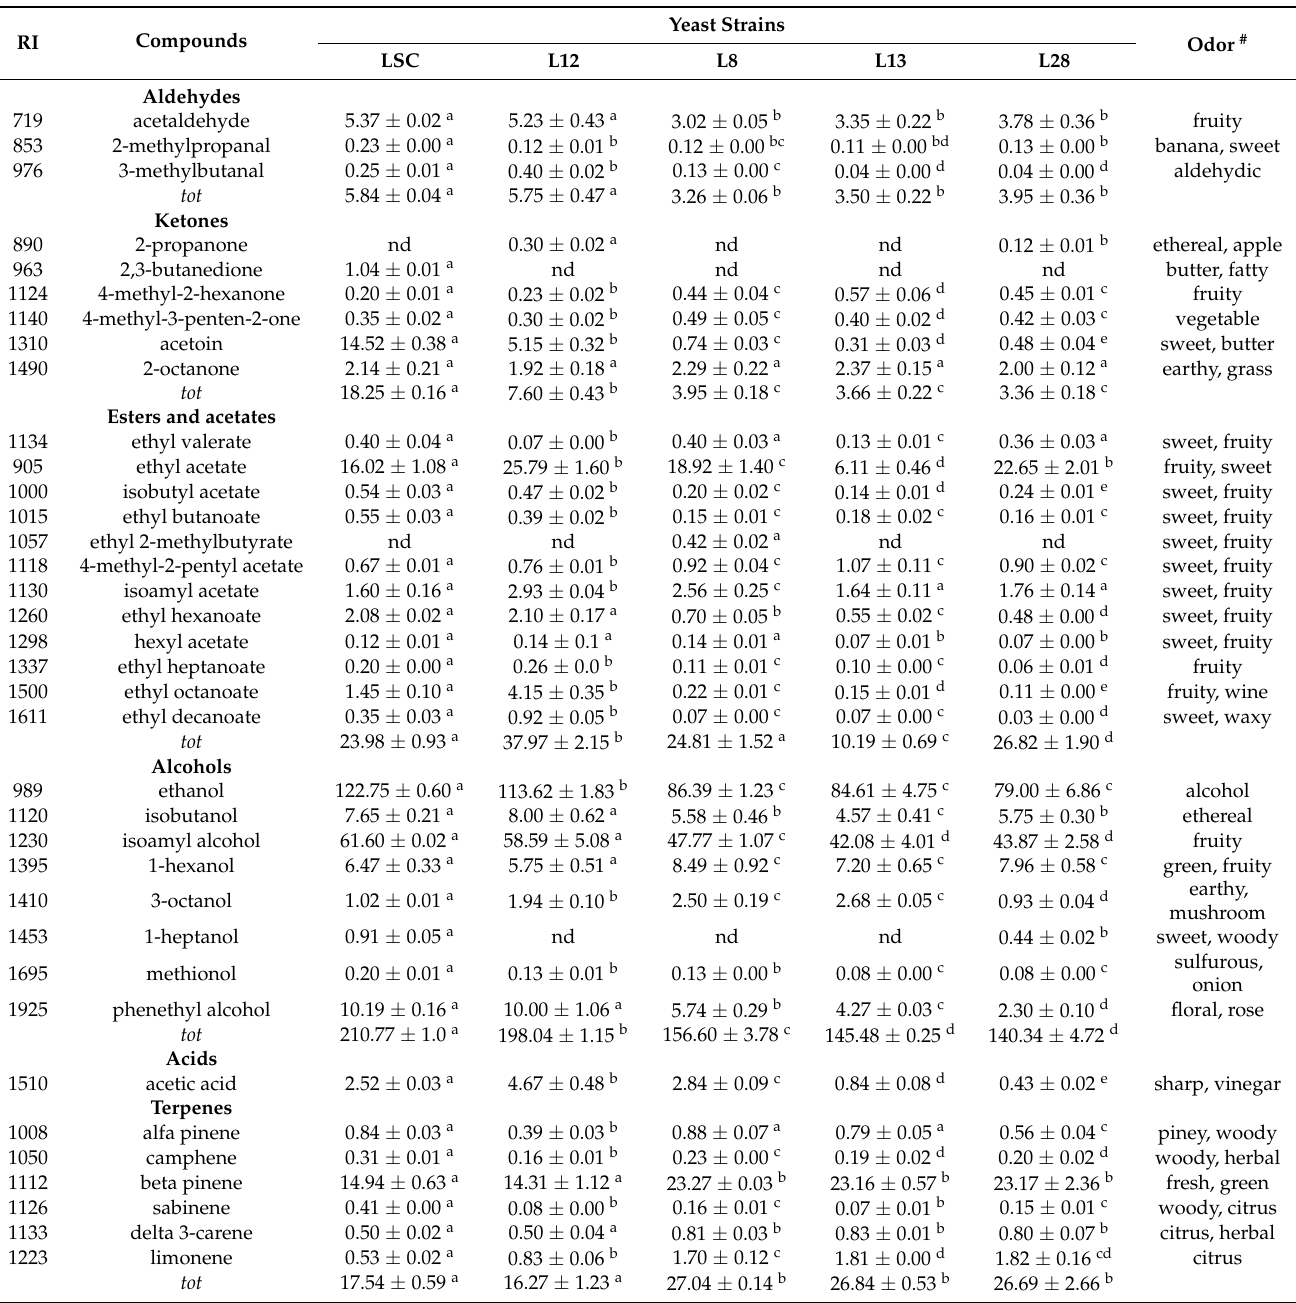
Table 2. Profiles of volatile organic compounds that were detected in doughs inoculated with different yeast